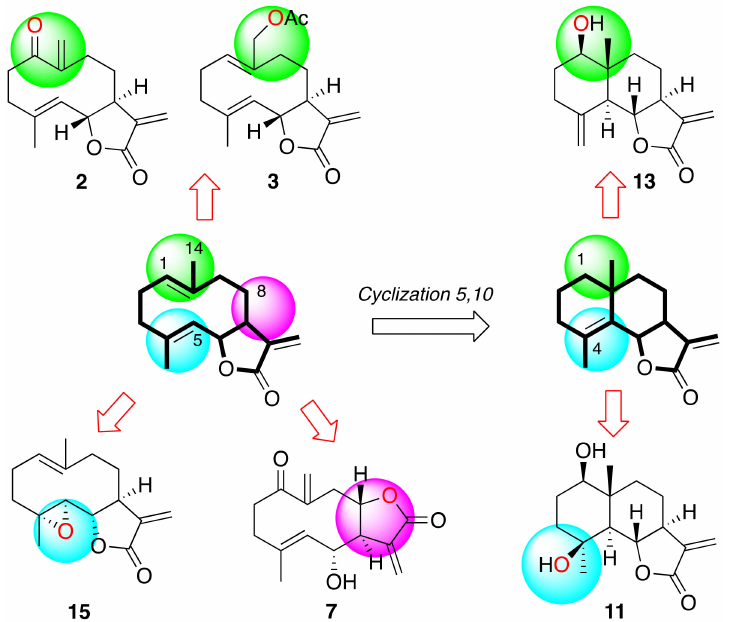
Figure 9. Structure–activity relationship of germanane and eudesmane metabolites against kineto- plastid